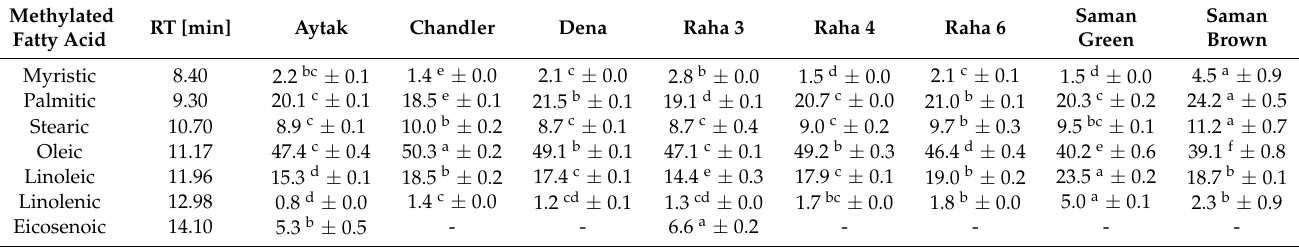
Table 2. The fatty acid profile of non-polar extracts of walnut